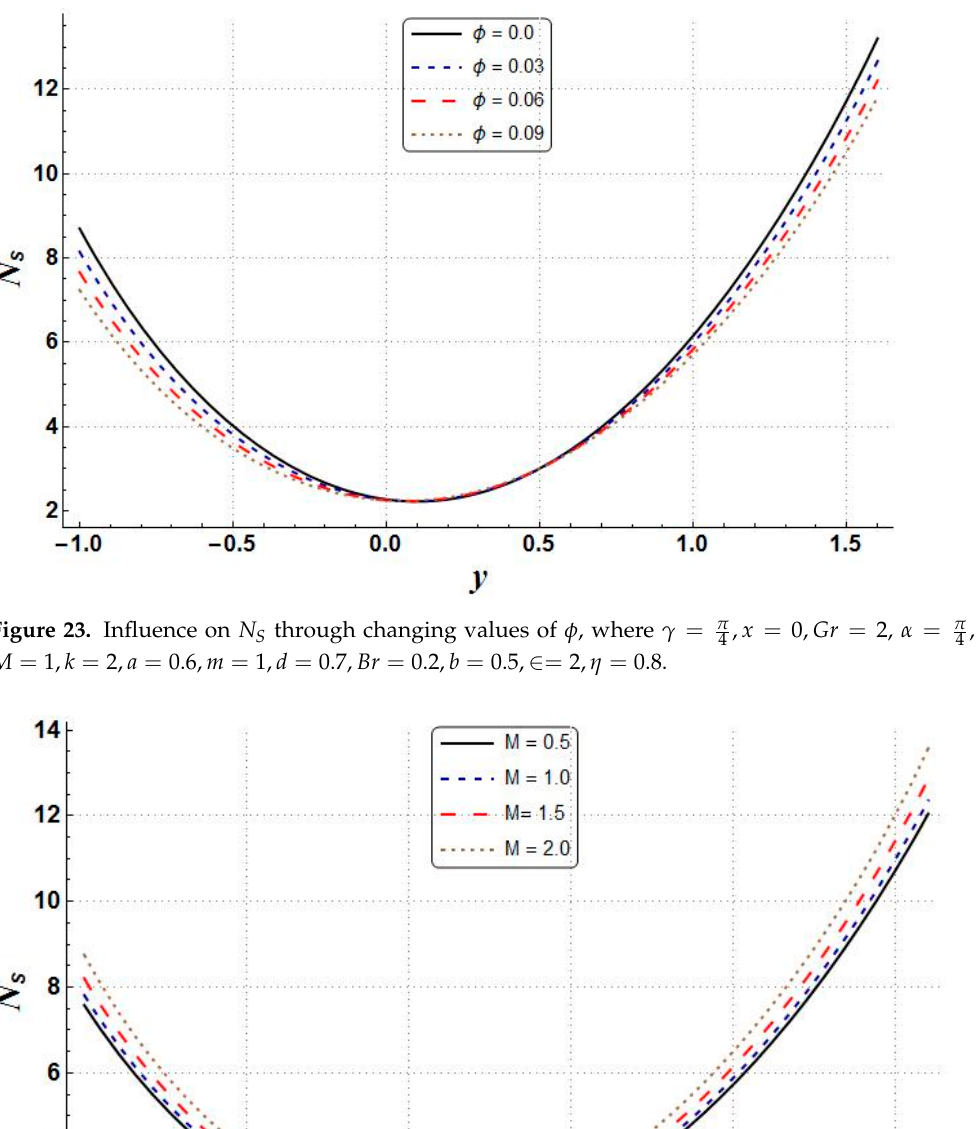
Figure 24. Influence on N S through changing values of M , where γ = π φ = 0.05, k = 2, a = 0.6, m = 1, d = 0.7, Br = 0.2, b = 0.5, ∈ = 2, η =